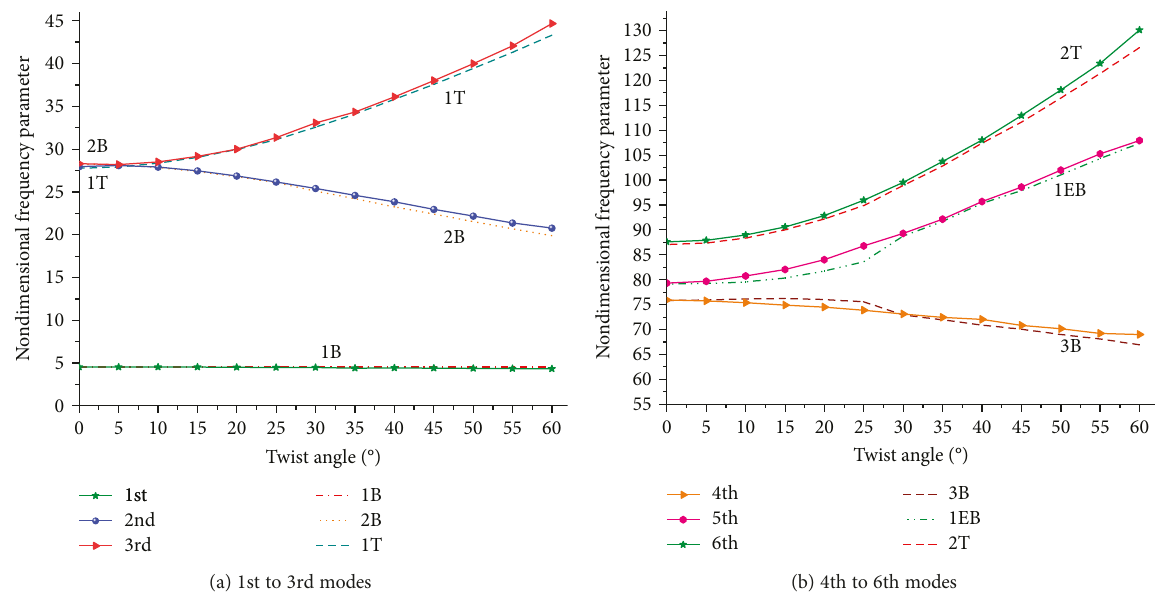
Figure 6: Variations of nondimensional frequency parameters with the twist angle ( l = 3 , h = 20 , n = 2 , and h